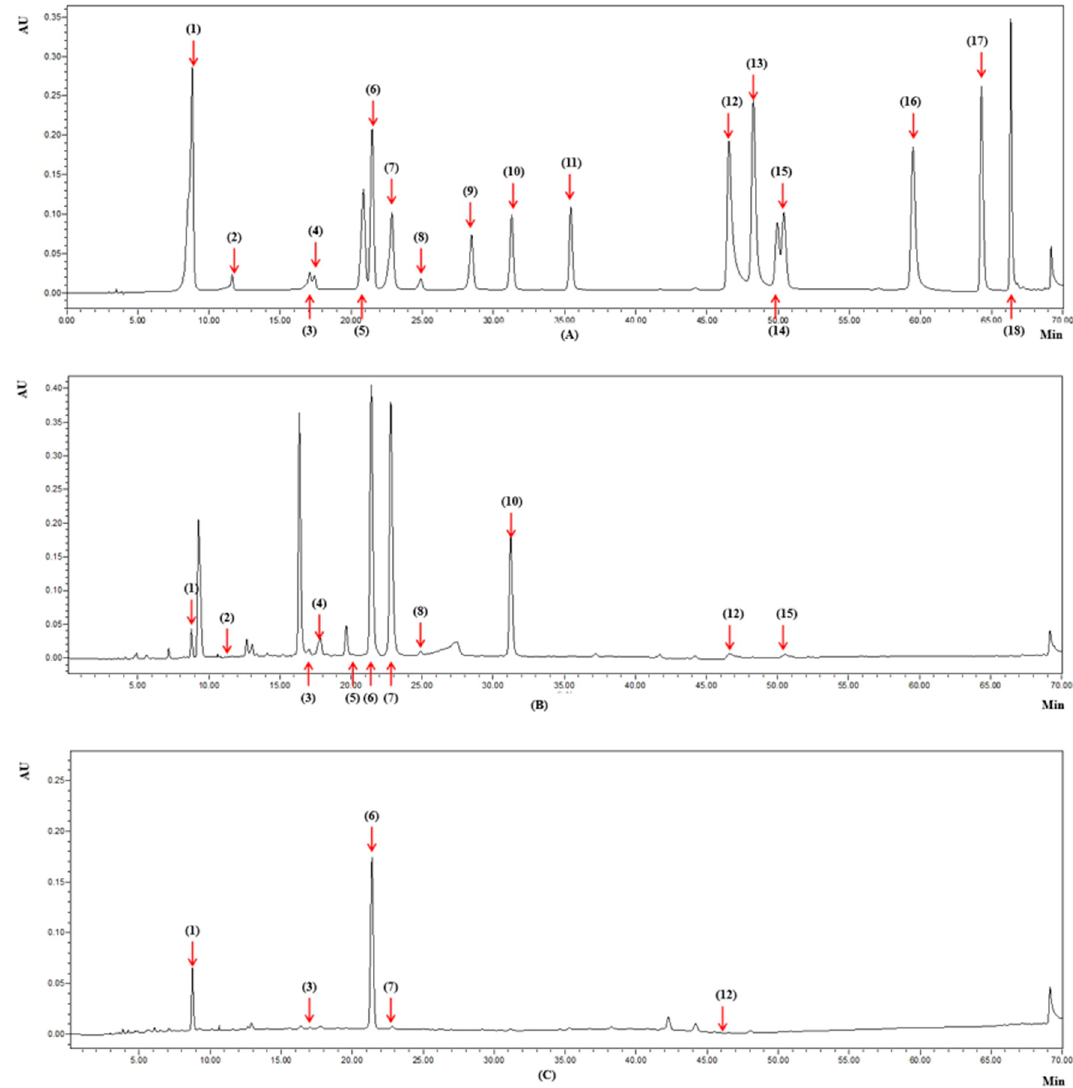
Figure 3. High-performance liquid chromatography (HPLC) Chromatograms under 254 nm of the standard compounds ( A ); Dianqing Tea ( B ); Tibetan Tea ( C ). The numbers in brackets referred to the compounds: gallic acid ( 1 ); gallocatechin ( 2 ); epigallocatechin ( 3 ); catechin ( 4 ); chlorogenic acid ( 5 ); caffeine ( 6 ); epigallocatechin gallate ( 7 ); epicatechin ( 8 ); gallocatechin gallate ( 9 ); epicatechin gallate ( 10 ); catechin gallate ( 11 ); ellagic acid ( 12 ); myricetin ( 13 ); quercitrin ( 14 ); kaempferol-3- O -glucoside ( 15 ); quercetin ( 16 ); theaflavine ( 17 ); kaempferol ( 18 ).